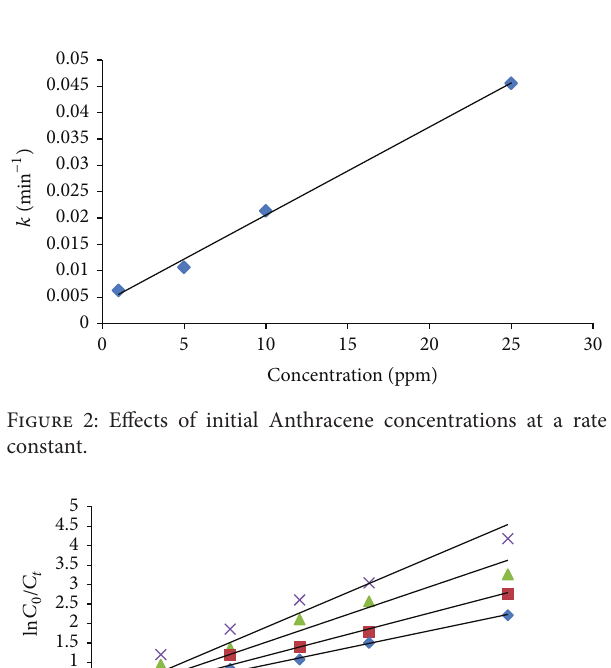
Figure 1: The changes of ln( 𝐶 0 /𝐶 𝑡 ) with irradiation times on different Anthracene concentrations by TiO 2 .